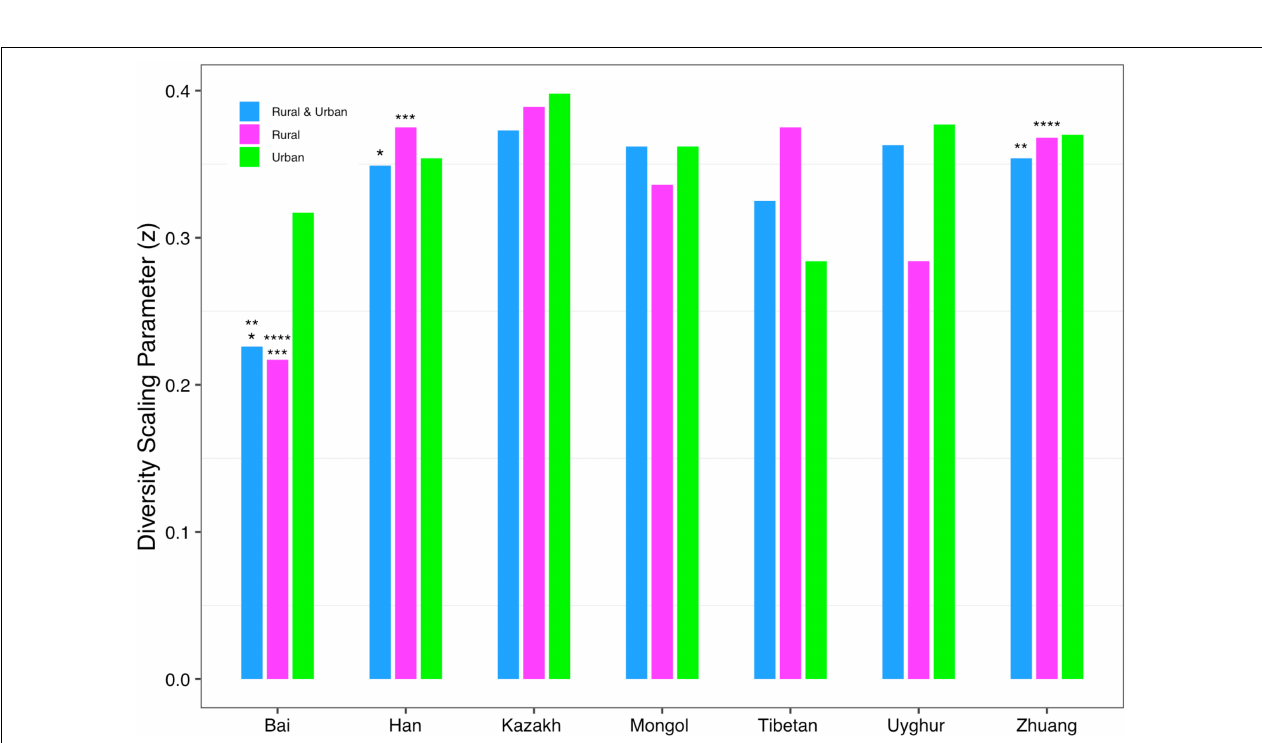
FIGURE 3 | The DAR profiles of all cohorts from Schemes 2A and 2B at the species level when diversity order q = 0 (the same number of “*, **, ***, ****” indicates a significant difference in pairwise comparison).